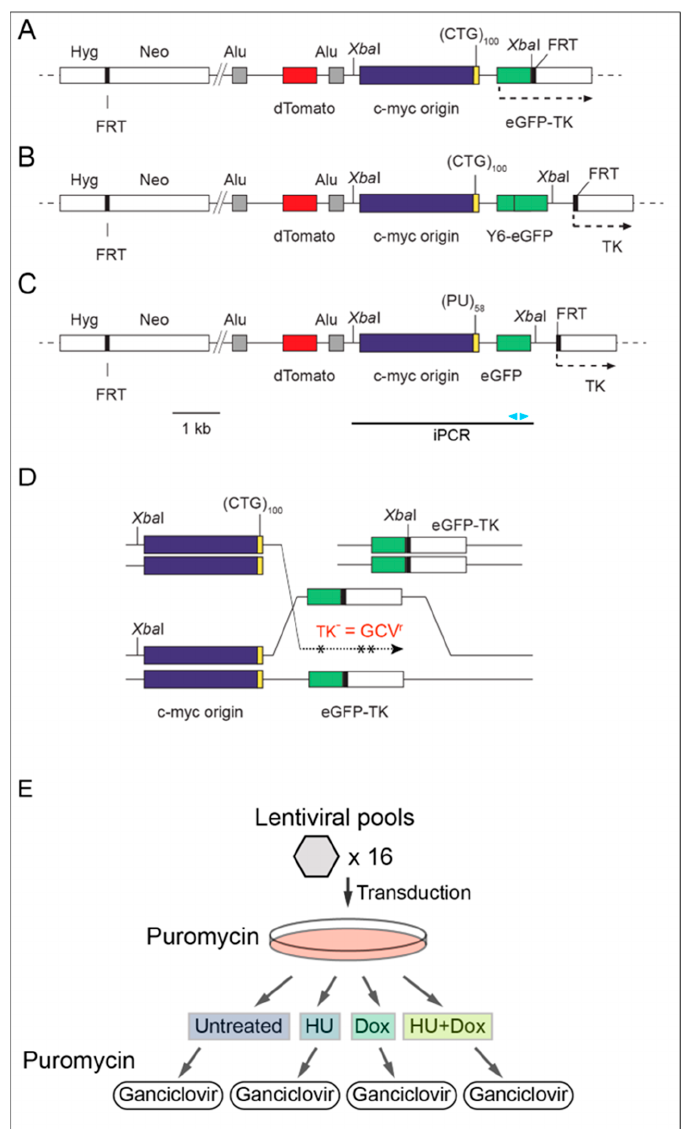
Figure 1. shRNA screen for suppressors of break-induced replication. Maps of the ectopic site constructs integrated into HeLa/406 cells. ( A ) DF/myc(CTG) 100 eGFP/TK contains a hairpin-forming CTG repeat in the lagging strand of DNA synthesis initiated at the c-myc origin. An eGFP-TK fusion gene serves as the marker for negative ganciclovir selection and detection of break-induced replication. ( B ) DF/myc (CTG) 100 /CMV-TK differs principally in that the TK locus is independently driven by the CMV promoter. ( C ) DF/myc(Pu/Py) 58 /CMV-TK possesses a G-quadruplex/triplex forming sequence as the replication barrier and the TK gene is driven by the CMV promoter. The Xba I restriction site region used to test for DNA rearrangements by iPCR is indicated and the expected iPCR product is shown at the bottom where arrowheads represent the outward-facing iPCR primers. ( D ) Model of BIR, where mutagenic replication (dashed line with asterisks) leads to TK negative alleles and ganciclovir resistance (GCV r ). ( E ) Process used for transduction and selection of cells undergoing break-induced replication (BIR) indicating the four treatment groups where doxycycline (Dox) is used to suppress POLD3 through Dox-inducible activation of an shRNA against POLD3 and hydroxyurea (HU) is used to induce replication